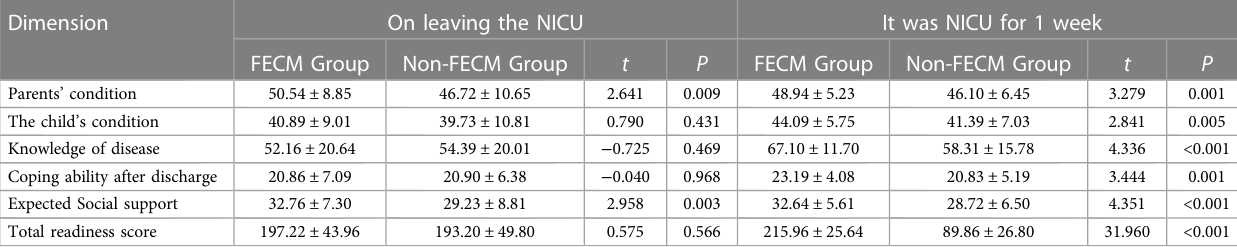
TABLE 3 The scores of RHDS-parents of primary caregivers of premature infants in the two groups at discharge and 1 week after discharge.